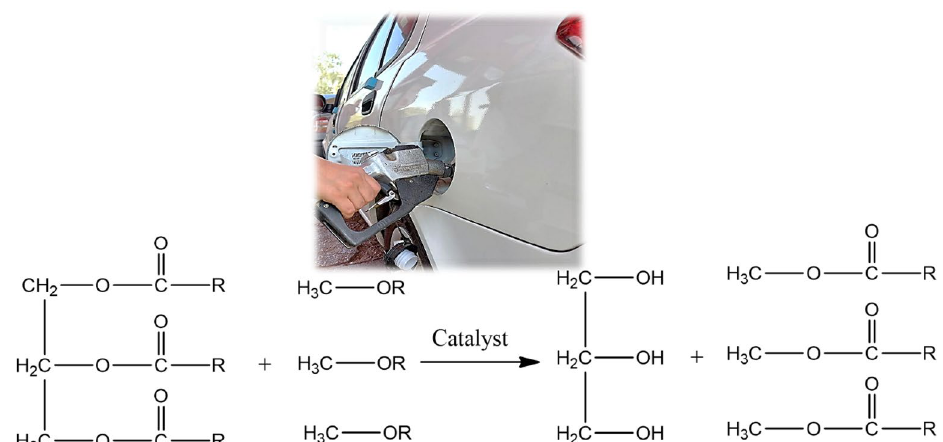
Figure 11. Transesterification of glycerol esters with MeOH over nanomagnetic SSE@GO-CuFe 2 O 4